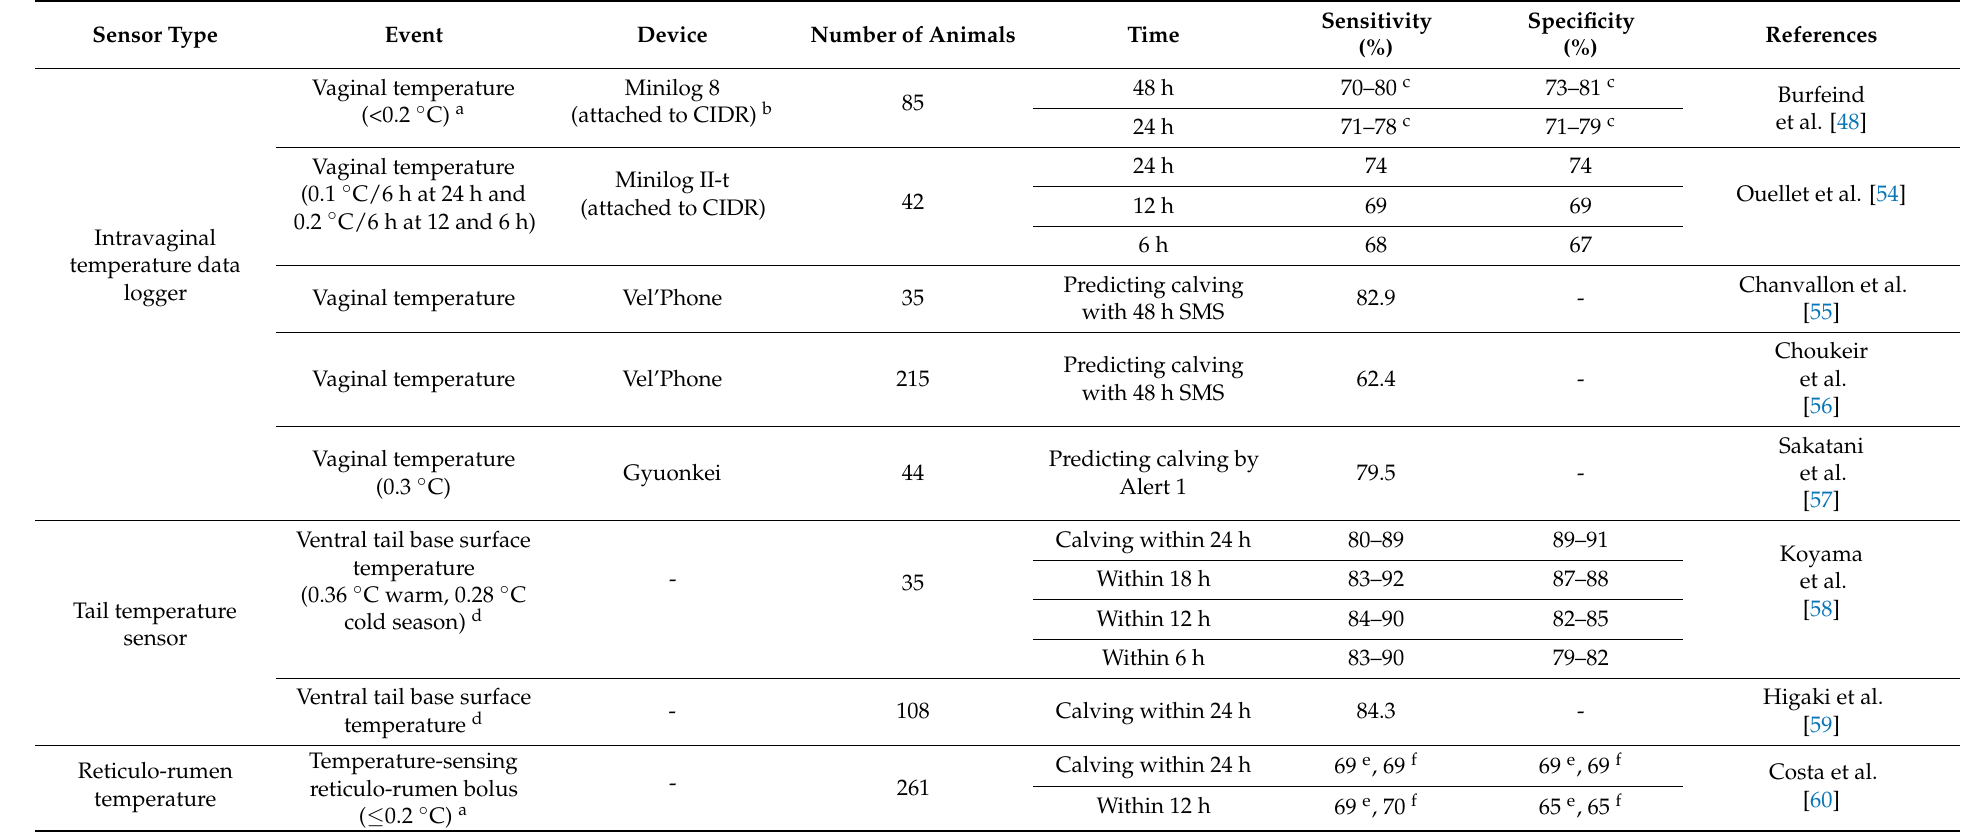
Table 2. Accuracy to predict calving by using different temperature loggers in dairy